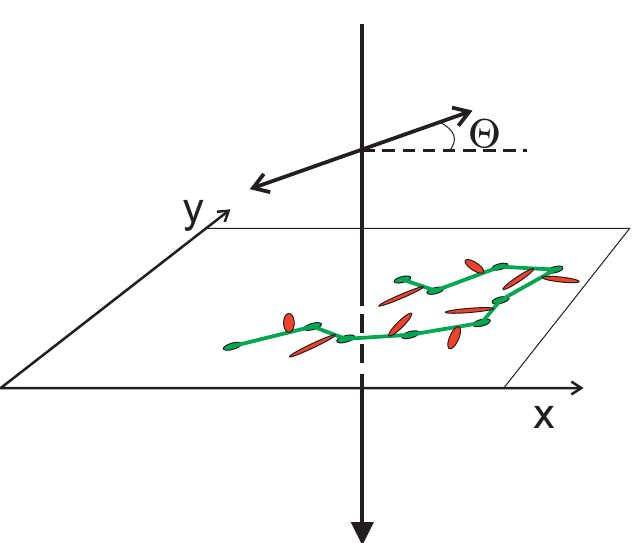
Figure 16. Scheme of 2D azo-dye system interacting with linearly polarized